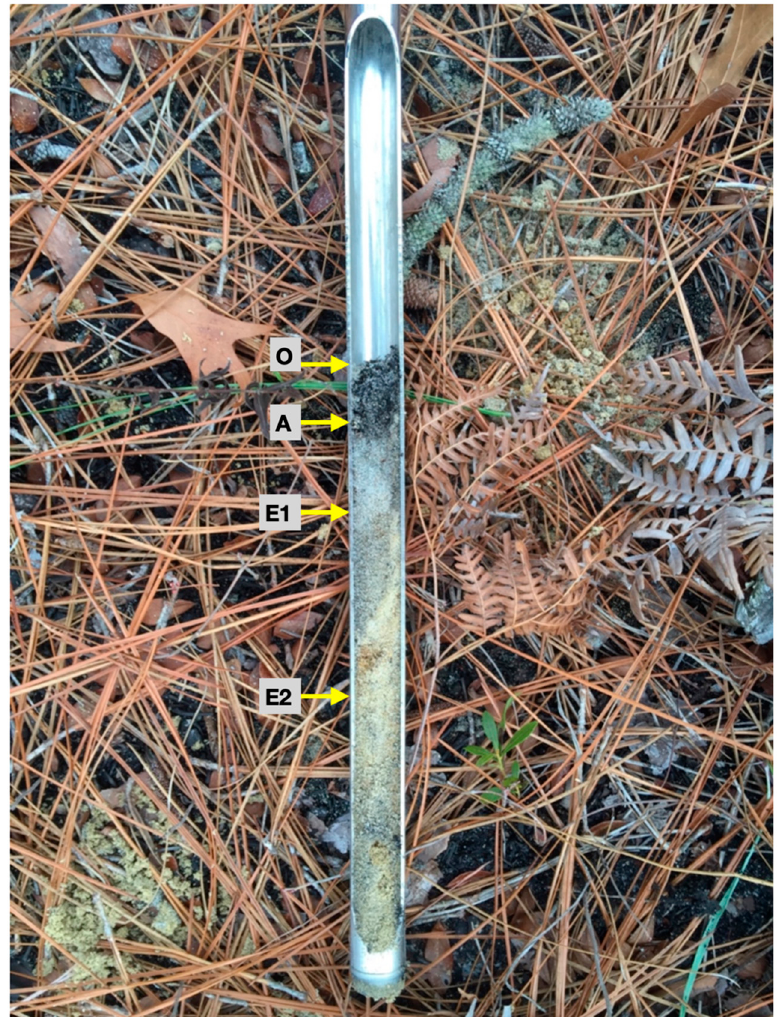
Figure 3. Typical abbreviated soil profile consisting of O, A, E1, and E2 for a Spodosol obtained using the Oakfield Model H soil probe at the Tom Yawkey Wildlife Center, Georgetown, SC, USA. Soil order was identified using the USDA Natural Resources Conservation Service Web Soil Survey. Due to frequent burning, Oe and Oa Horizon materials were not readily present for the majority of our samples and were therefore not included in our analyses of mineral soil properties.